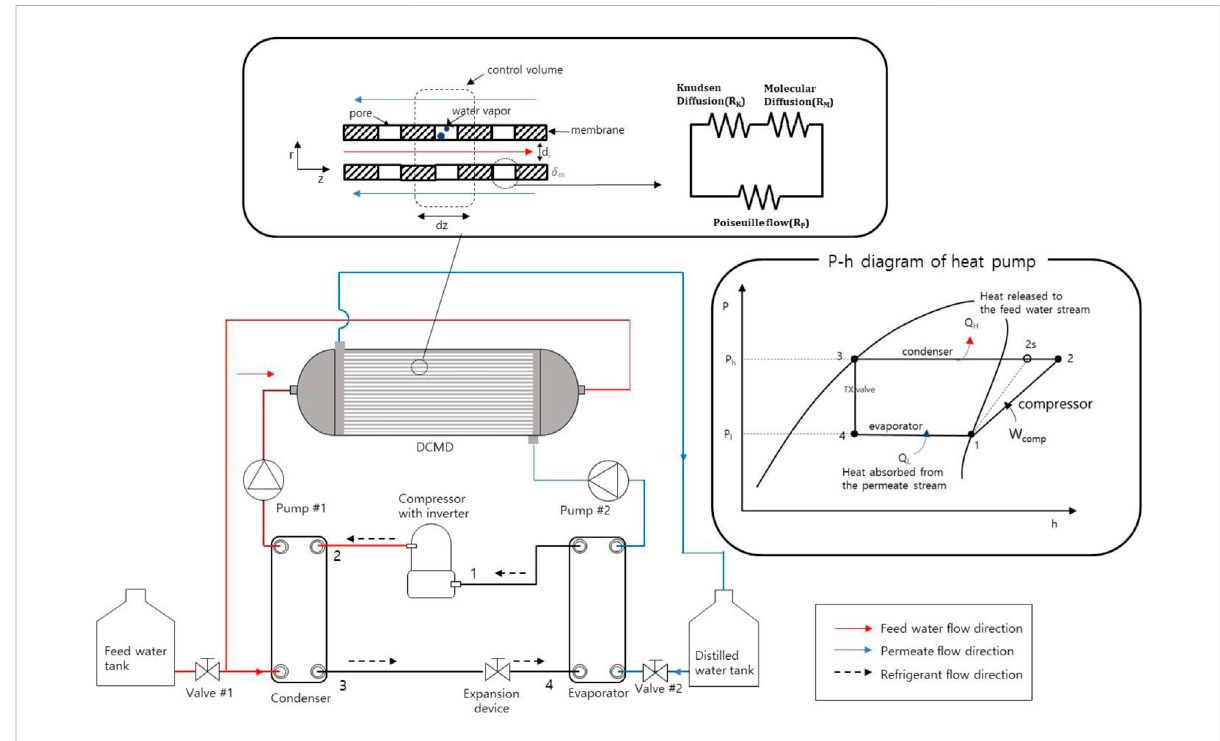
FIGURE 1 Schematic diagram of a heat pump-driven direct contact distillation.